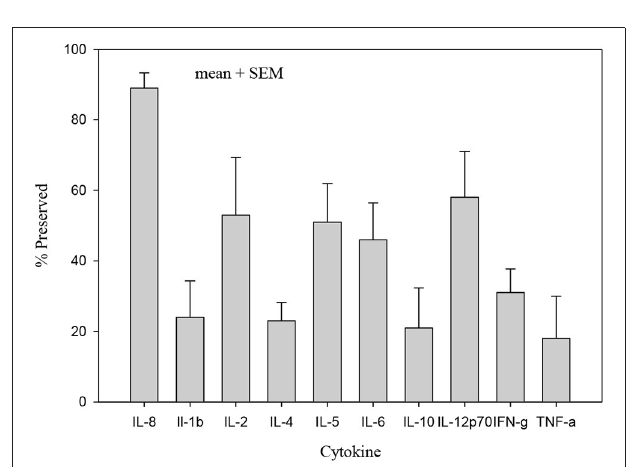
FIGURE 2 | IL-8 concentration before and after pasteurization. The concentration of IL-8 of 24 milk samples measured in duplicates in thawed milk. The concentration after pasteurization was not changed significantly, p = 0.543.